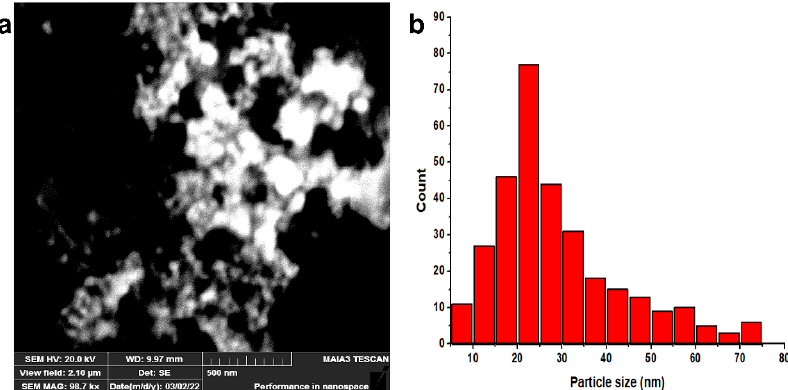
Figure 3. SEM analysis of AgNPs ( a ) SEM ( b ) Particle size distribution.